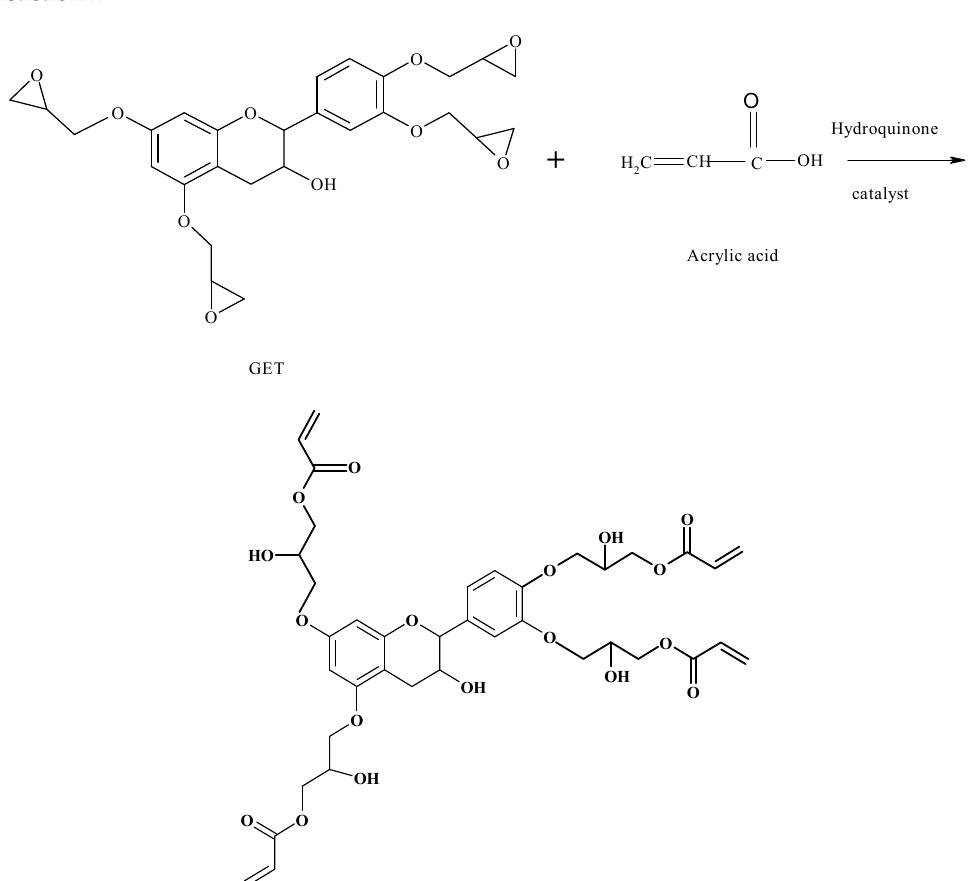
Figure 5. Reaction scheme of glycidylation of the tannin with acrylic acid (tannin-based epoxy acrylate).